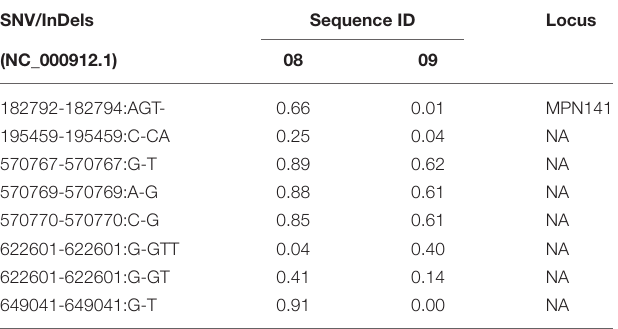
TABLE 4 | Variant frequencies of the isolates C036-1 and C036-2 with different colony morphologies.